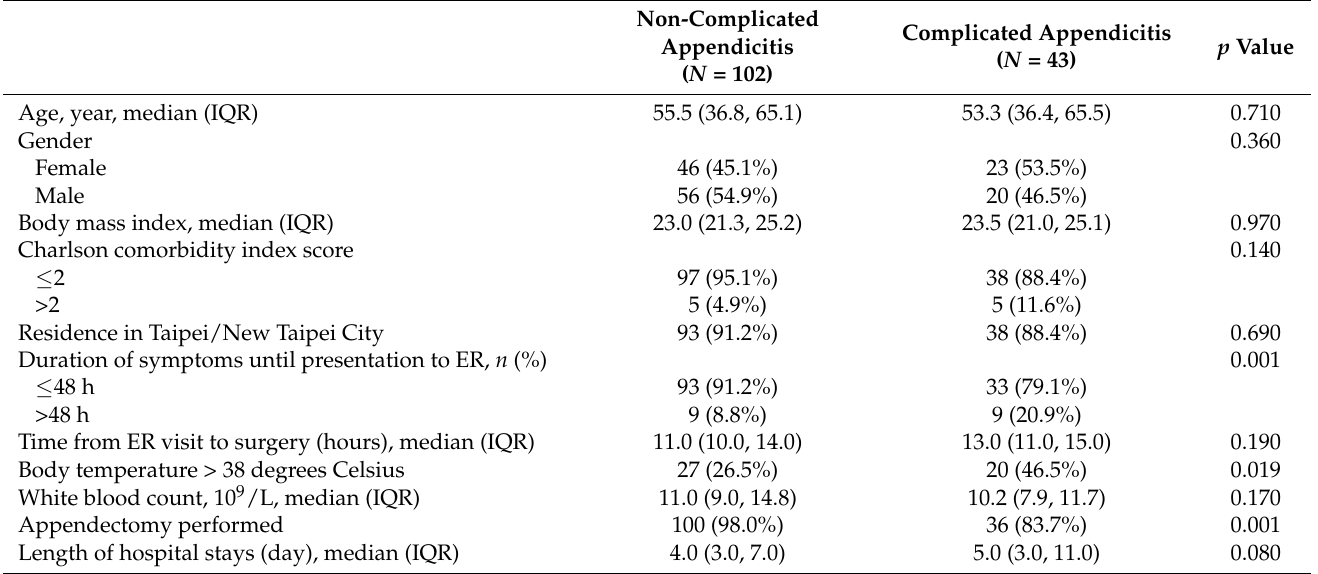
Table 1. Clinical variables among 145 adult patients with acute appendicitis during the COVID-19